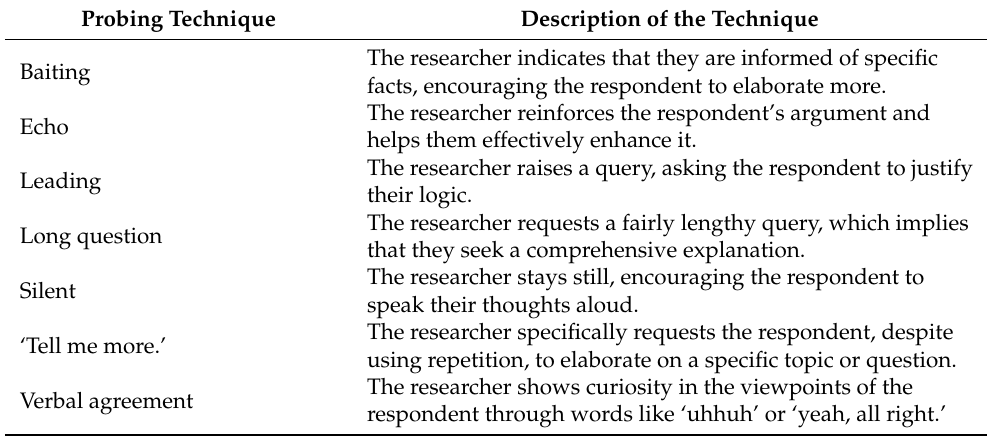
Table 2. Techniques for probing which can be used during